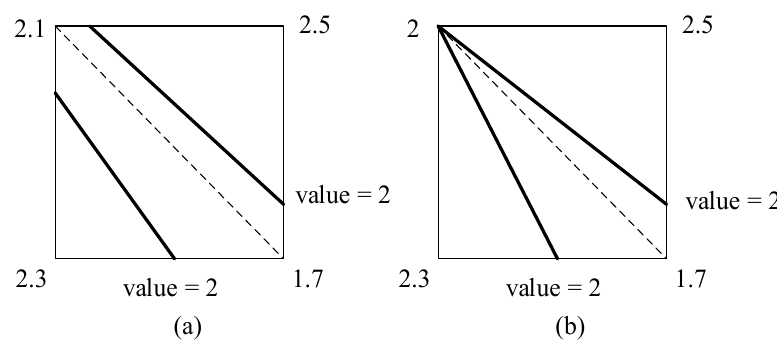
Figure 10. Equivalent point calculation: ( a ) the contour line passes through the two vertices; ( b ) the contour line crosses one of the vertices.